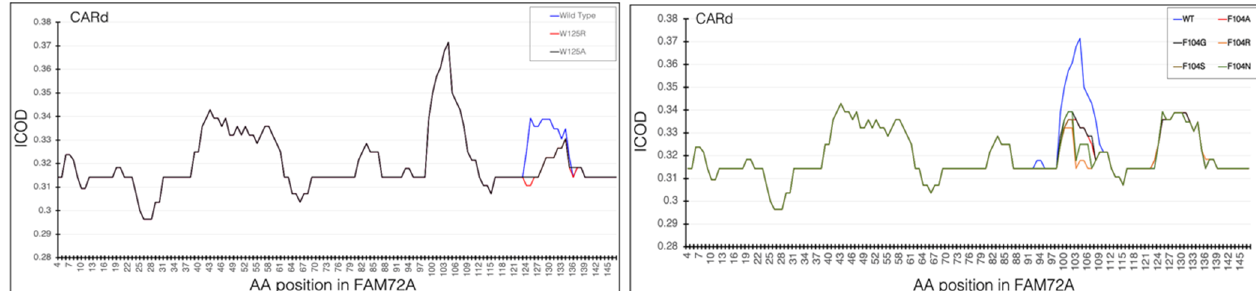
Figure 10. CARd analysis showing the effect of FAM72A mutations at the AA tryptophan Trp W125 (W125 → W125A and W125R) and F104 phenylalanine (F104 → F104A, F104R, F104N, F104G, and F104S; within the FWMF motif (AA 101–104)) on the dynamic nature of the FAM72A protein and UNG2 (AA 1–45) peptide heterodimer binding. CARd analysis confirmed the FAM72A-UNG2 interaction and the effect of the various FAM72A mutations on it, as carbon governs cohesiveness at the active site in proteins. Accordingly, internal carbon optimized domains (ICODs) of FAM72Awt and UNG2 (AA 1–45) interaction validate a strong overlap of FAM72A-UNG2 binding. In particular, mutations in FAM72A turn the ICODs of FAM72A at AAs 100–104 and 125–135 into non-ICODs, encouraging a less favorable and weaker FAM72A mut -UNG2 induced-fit-binding than that of FAM72A wt -UNG2. F104A, F104G: change from hydrophobic (W) and carbon-rich (W) to hydrophobic and carbon-low; F104R: change from hydrophobic (F) and carbon-rich (F) to hydrophilic, carbon-rich, and basic AA); F104S, F104N: change from hydrophobic (F) and carbon-rich (F) to hydrophilic, carbon-low, and polar AA. CARd reveals that F104 tends to switch to F104R > F104S > F104N > F104G > F104A. Code information: F104: uuu, A104: